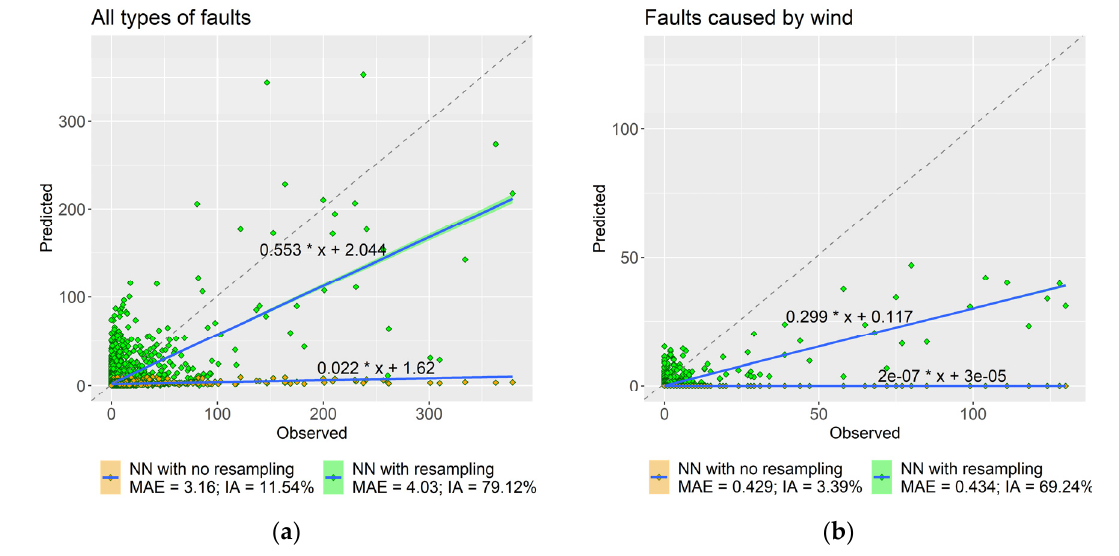
Figure 5. Weather-based fault prediction in the electricity network: comparison of NN models in two experiments with and without resampling. ( a ) All faults, ( b ) Faults caused by wind.